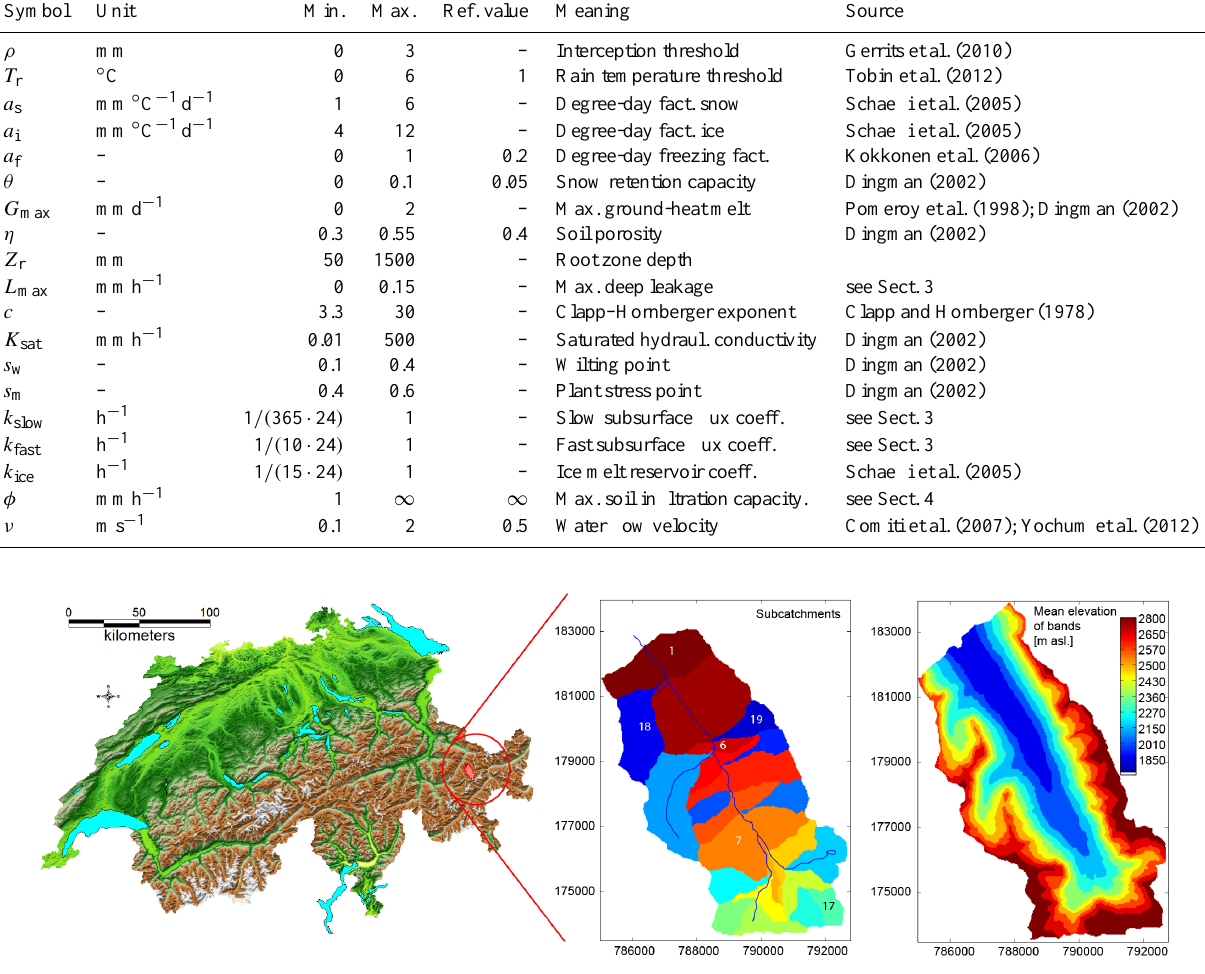
Figure 3. Location of the Dischmabach catchment within Switzerland (source: SwissTopo, 2005, 2008) and the 23 subcatchments identified with TauDEM Version 5 (Tarboton, 1997). The 10 elevation bands in the right plot are used for comparison purposes in Sect. 5.1. The latitude and longitude are indicated in the Swiss coordinate system (in